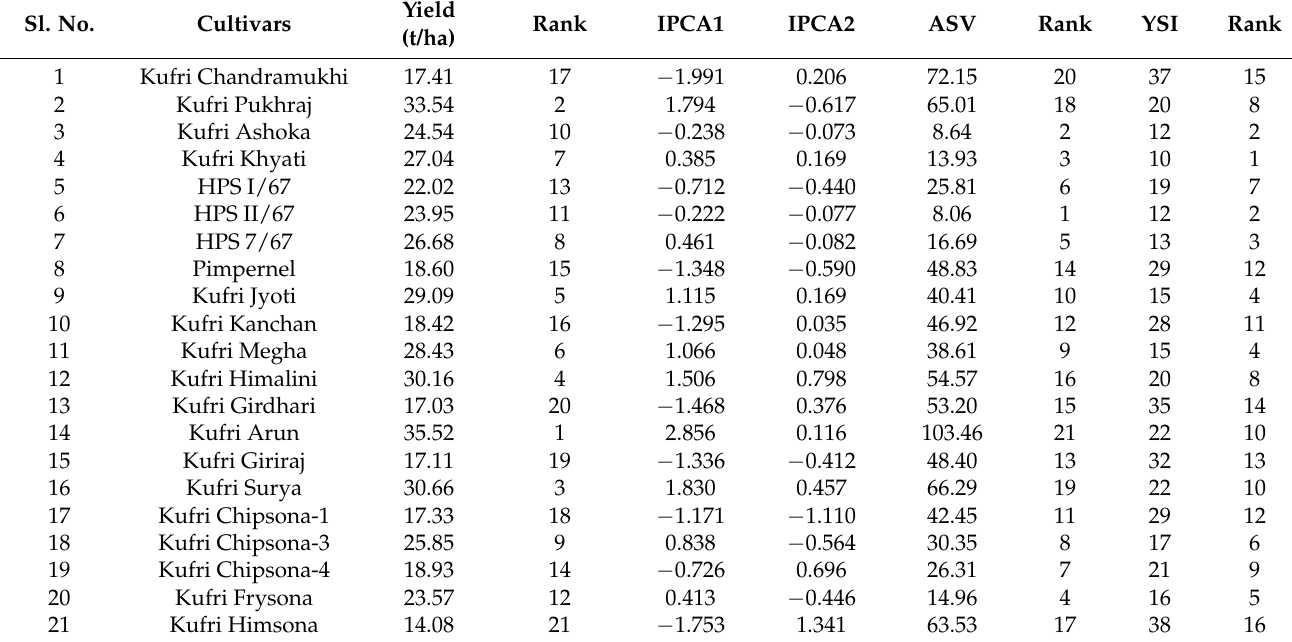
Table 3. Potato yield (two years pooled data) stability analysis over two environments. Sl.